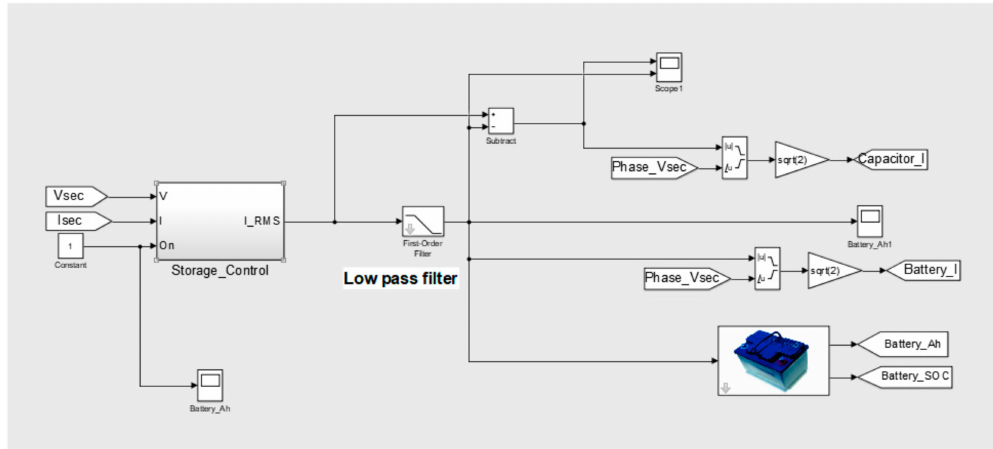
Figure 4. Simulink model of storage control